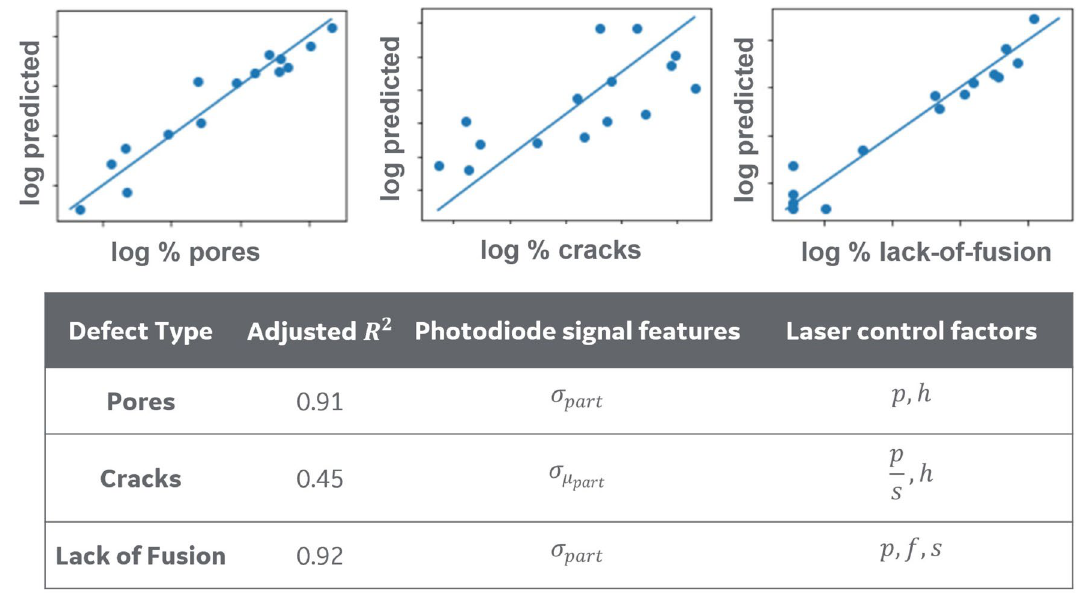
Figure 4. Performance of defect predictor of different types of defects. A high concentration of points along the 45° line indicates high